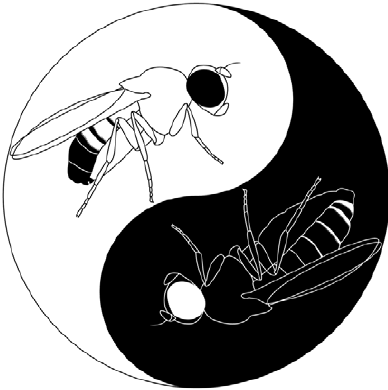
to provide non-experts with insight into the significance of the published